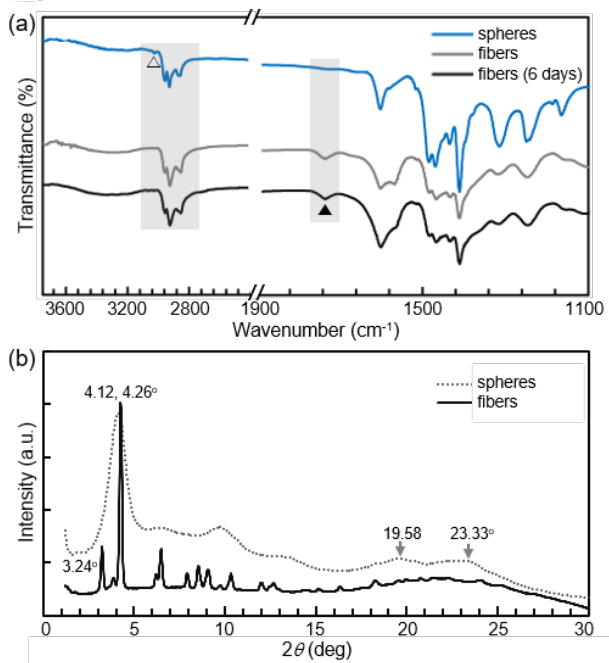
Figure 8. ( a ) FT-IR and ( b ) XRD patterns of spherical and 1D fibrous structures in ( a ), “6 days” denotes a sample dried in a vacuum for 6 days.